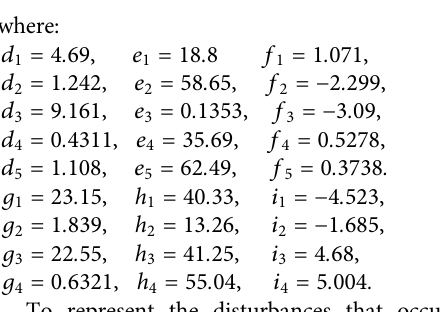
TABLE 2 | Comparison of results with Ref Seid et al., 2016. Simulation Maximum knee fl exion Normal